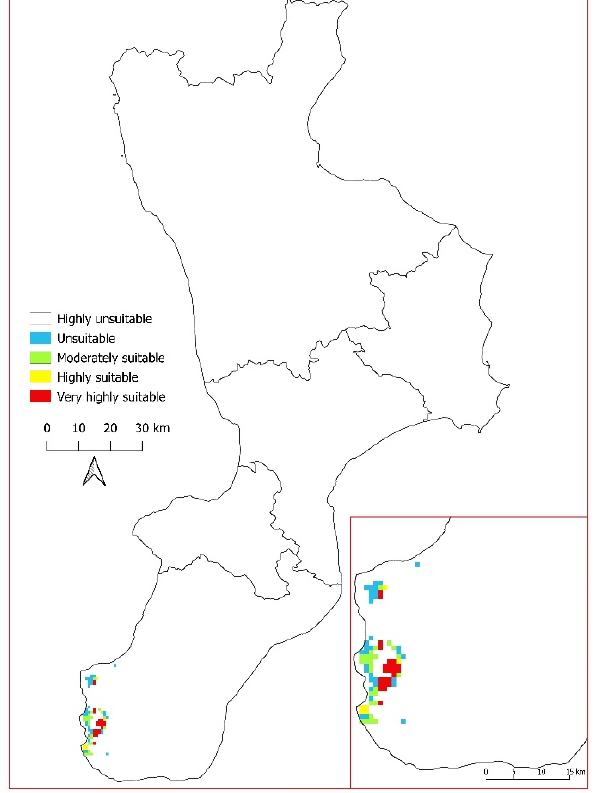
Figure 8. Prediction of the current potential distribution of Salvia ceratophylloides Ard. In relation to geological substrate. In white, highly unsuitable habitat ( ≤ 0.20); in blue, unsuitable (0.21–0.40); in green, moderately suitable (0.41–0.60); in yellow-low, highly suitable (0.61–0.80); and in red, highly suitable ( ≥ 0.80).